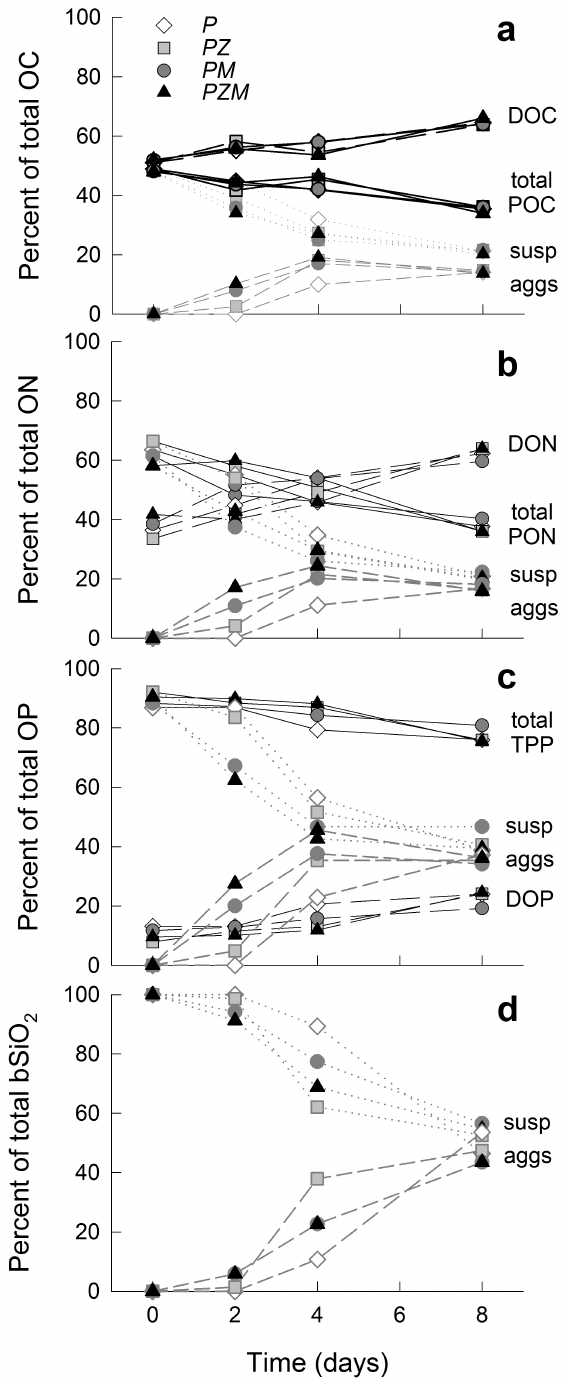
Fig. 5. The percent of the total (a) organic carbon, (b) organic ni- trogen, (c) organic phosphorus, and (d) biogenic silica that is in the dissolved organic, total particulate organic (or biogenic), suspended particulate, or aggregate form. Data for suspended and aggregated material are presented to the distribution of particulate matter be- tween these two